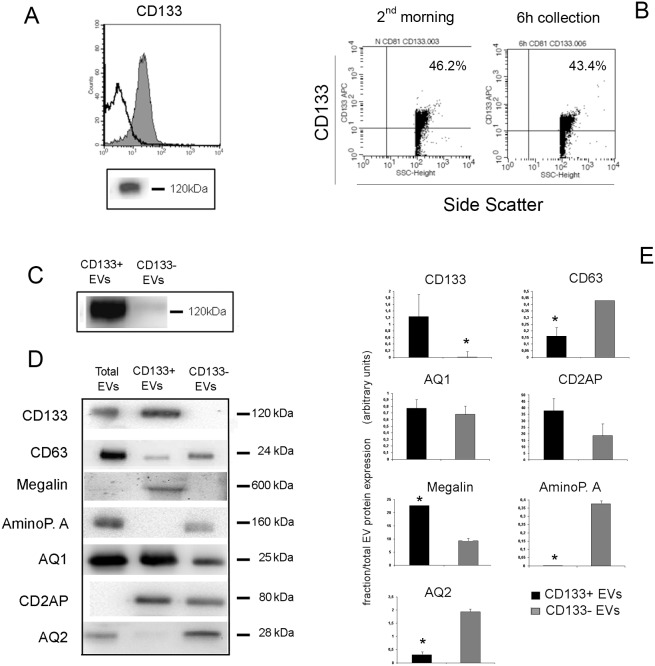
Expression of CD133 by urinary vesicles.Panel A. Representative cytofluorimetric and Western Blot (clone AC133) images of the expression of CD133 by urinary vesicles of normal subjects. The cytofluorimetric histogram shows CD133 detection (grey area) and isotypic control (dark line). Panel B. Scatter and fluorescence dot plots showing similar CD133+ EV levels in normal urine of a second morning minction or of a 6-hours collection. Plots are representative of three experiments with similar results. Panel C. Representative image of CD133 detection in CD133+ and CD133− sorted EVs (clone W6B3C1). Panel D and E. Representative images and quantification of the expression of different nephron markers by the total urinary EVs and by CD133+ and CD133− sorted EVs. Data are mean ± SD of at least three different experiments and report the marker expression in the sorted fractions normalized on the expression in the Total EVs. AminoP.: Aminopeptidase A, AQ: Aquaporin, CD2AP: CD2 Associated protein. * = p<0.05.